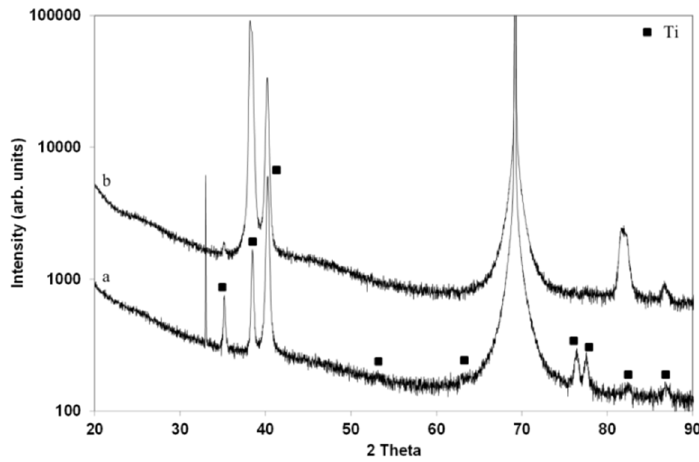
Figure 2. X-ray diffraction patterns of as-deposited Ti films ( a ) and Ti films, 500 nm thick, heated at 400 °C and processed in (Ar ‐ 33%N 2 ‐ 1%H 2 ) plasma for 4 h ( b ).